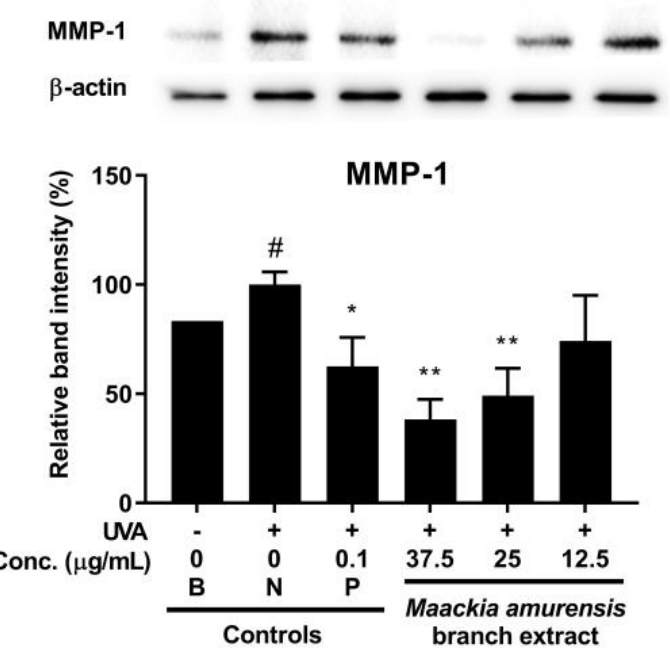
Figure 6. Effect of Maackia amurensis branch extract on UVA-induced matrix metalloproteinase (MMP)-1 expression in CCD-986Sk cells. CCD-986Sk cells were treated with epigallocatechin gallate or various concentrations (37.5, 25, and 12.5 µ g/mL) of M. amurensis branch extract for 24 h in the presence or absence of UVA irradiation (15 J/cm 2 ). After treatment, a western blotting analysis of MMP-1 was performed. M. amurensis branch extract significantly inhibited the UVA-induced expression of MMP-1. Data are presented as mean ± SD of three independent experiments. # p < 0.05 between blank and NC groups. * p -value between NC and M. amurensis branch extract groups (* p < 0.05 and